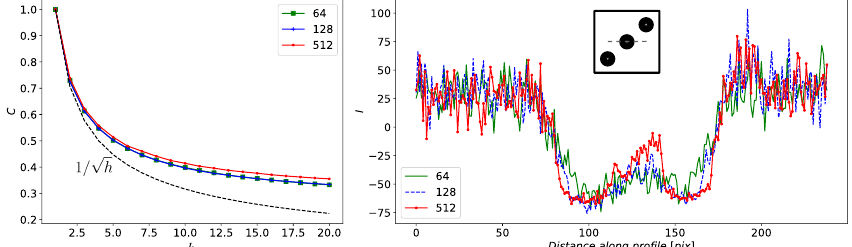
Figure 6. Comparison of speckle reduction and image quality for different cell sizes. ( Left ): speckle coefficient. ( Right ): Line profile for the final averaged images corresponding with different values of patch sizes G . The profiles have been vertically shifted by subtracting each corresponding mean.